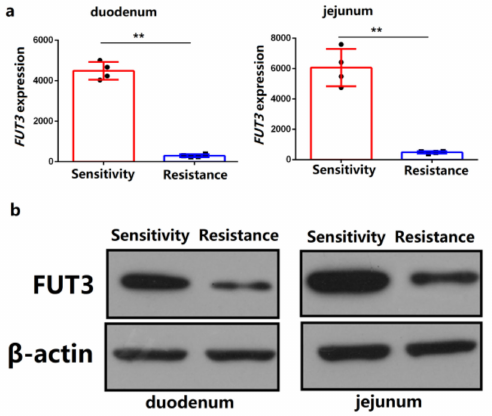
Figure 2. Differential expression analysis of pig FUT3 gene in intestinal tissues between Sutai E. coli F18-resistant and -sensitive piglets. ( a ) qRT-PCR detection, n = 3 biological replicates, ** p < 0.01. ( b ) Immunoblot analysis, β -actin, internal